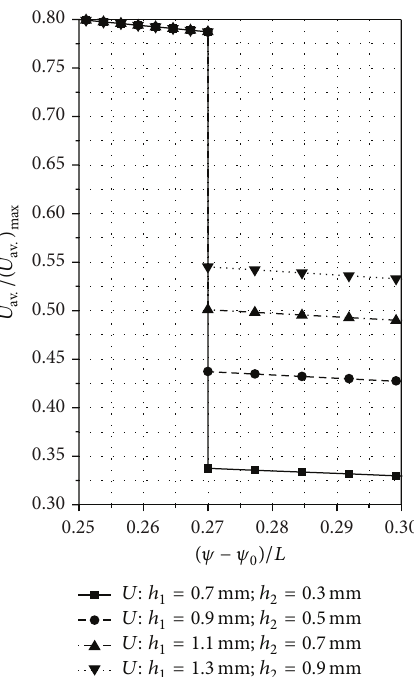
Figure 7: Detail of Figure 6 concerning the pressure jump between ℎ ℎ 1 and 2 . (The marked points are those where we made the calculation.)